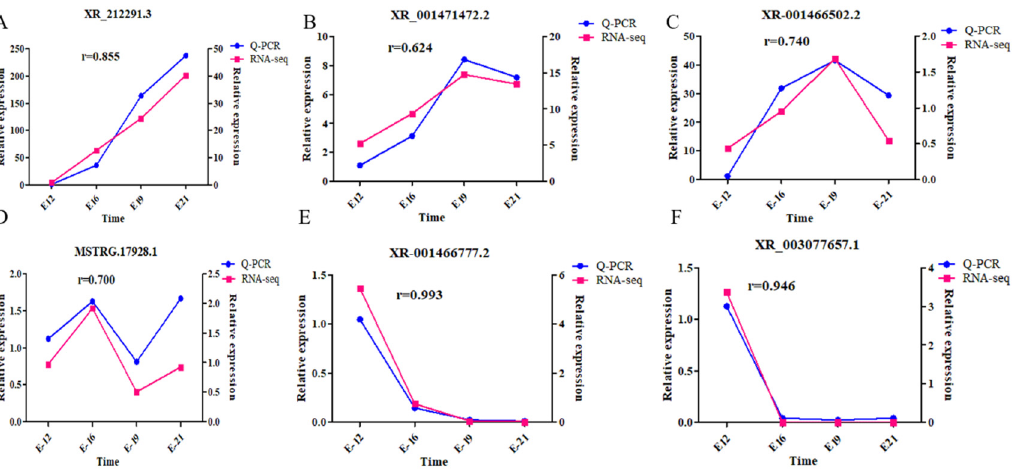
Figure 7. Target lncRNA validation. ( A ) XR_212291.3; ( B ) XR_001471472.2; ( C ) XR_001466502.2; ( D ) MSTRG.17928.1; ( E ) XR_001466777.2; and ( F ) XR_003077657.1.